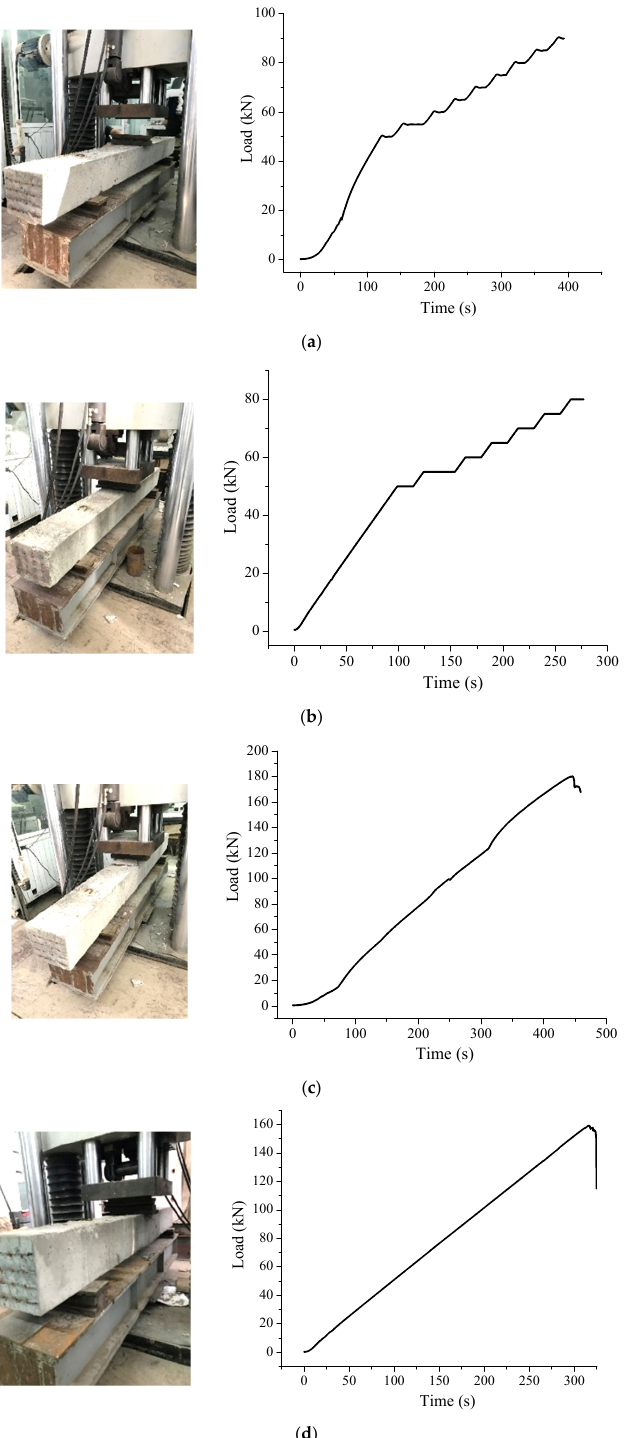
Figure 14. Results of negative bending moment test. ( a ) Test load for first crack (PSB3); ( b ) Test load for first crack (PSB4); ( c ) Maximum test load (PSB3); ( d ) Maximum test load (PSB4). Table 5. Results of negative bending moment tests for PSB3 and PSB4.